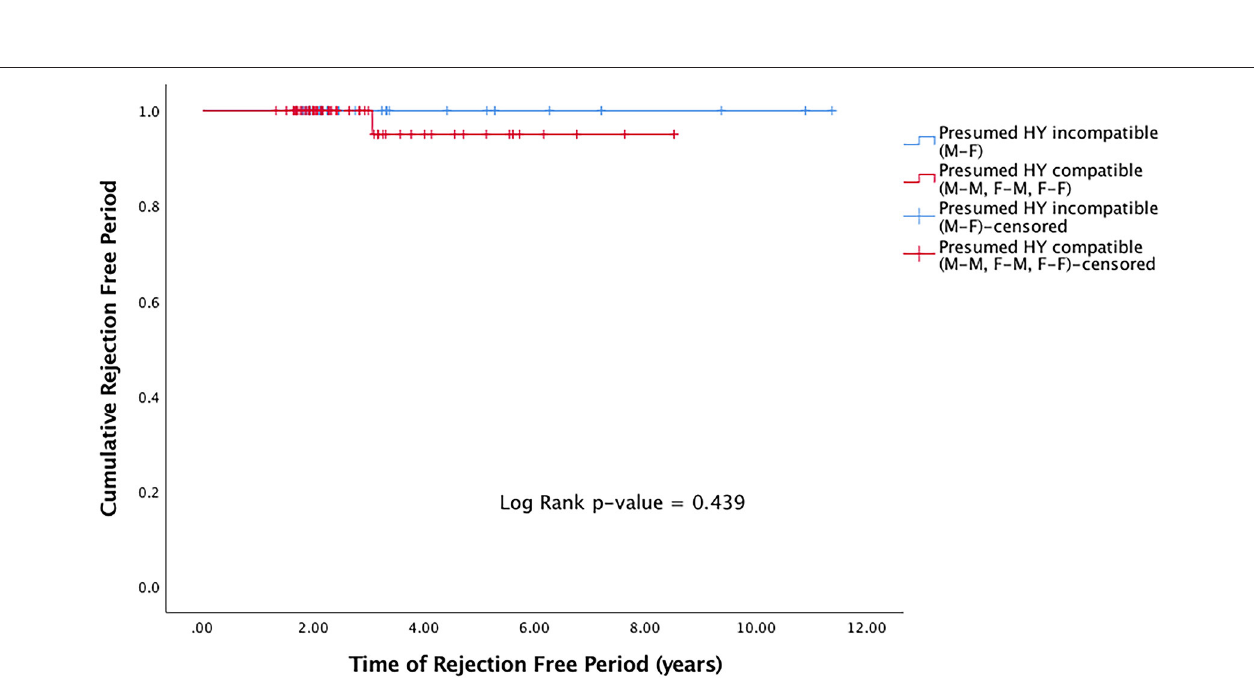
procedures, the effects of sex-matching are therefore more likely to be observed. In our study of DALK surgeries, the rates of graft failure and rejection were low at 7.2 and 2.2%,